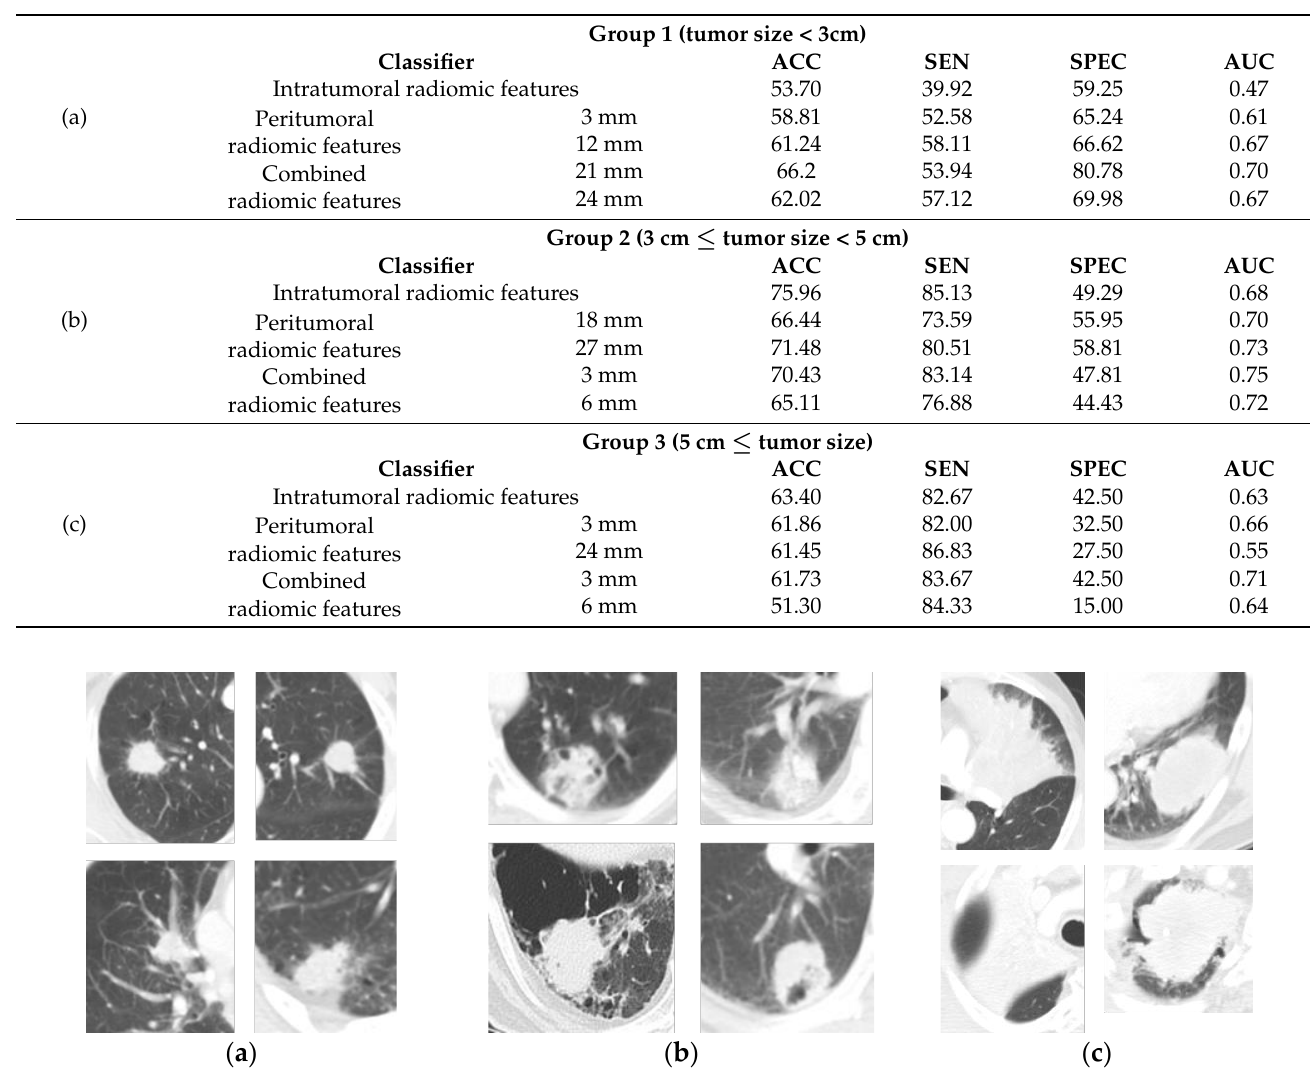
Table 5. Classification performance by tumor size group.